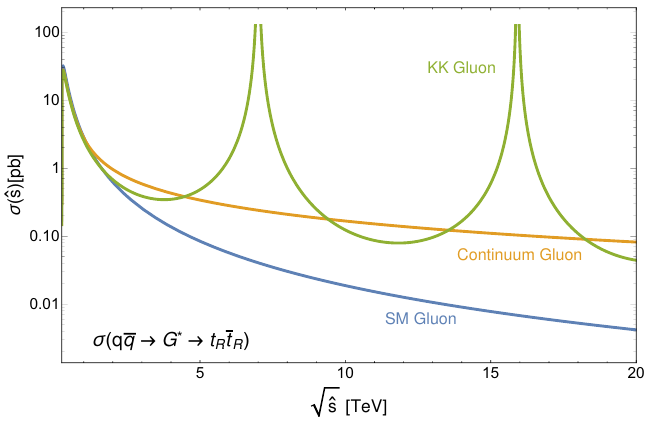
Figure 9 . The partonic cross section (cid:27) ( q (cid:22) q ! G (cid:3) ! t R (cid:22) t R ) in three simpli(cid:12)ed models: only SM gluon, with KK gluons, and with continuum gluons. While the presence of KK gluons leads to resonances in the partonic cross section, the continuum only leads to a smooth rise above the SM